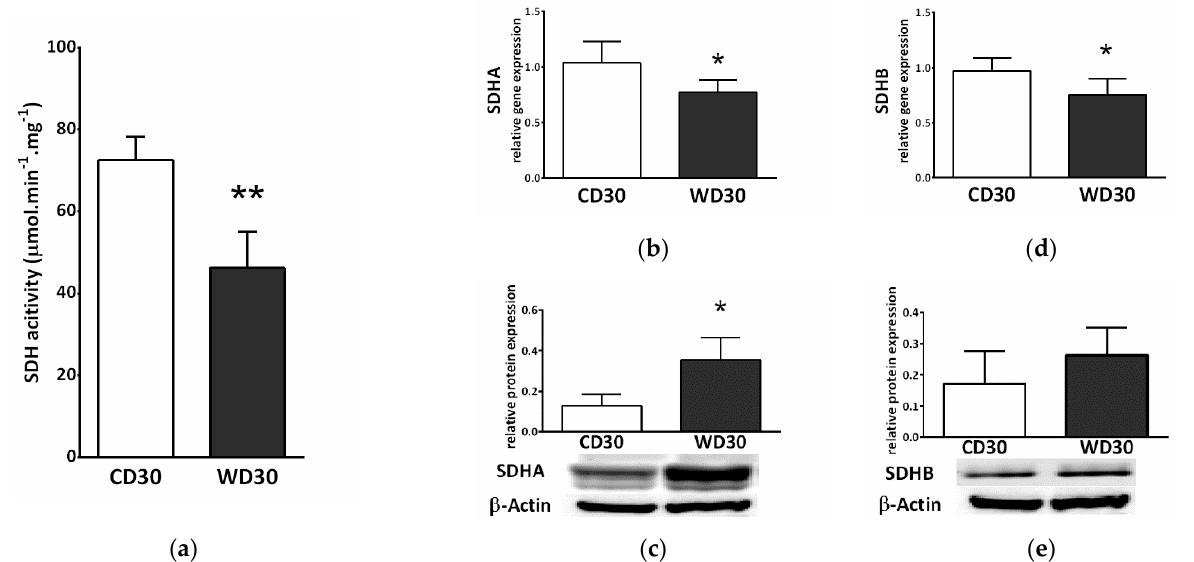
Figure 4. Hepatic succinate dehydrogenase (SDH) in mice fed a control diet (CD30) or a Western ‐ style diet (WD30) for 30 weeks. ( a ) Specific activity of SDH. ( b ) Relative gene expression of SDH subunit A. ( c ) Relative protein expression of SDH subunit A. ( d ) Relative gene expression of SDH subunit B. ( e ) Relative protein expression of SDH subunit B. Results are expressed as the means ± SD; * p < 0.05, ** p < 0.01 (n = 6 each group).